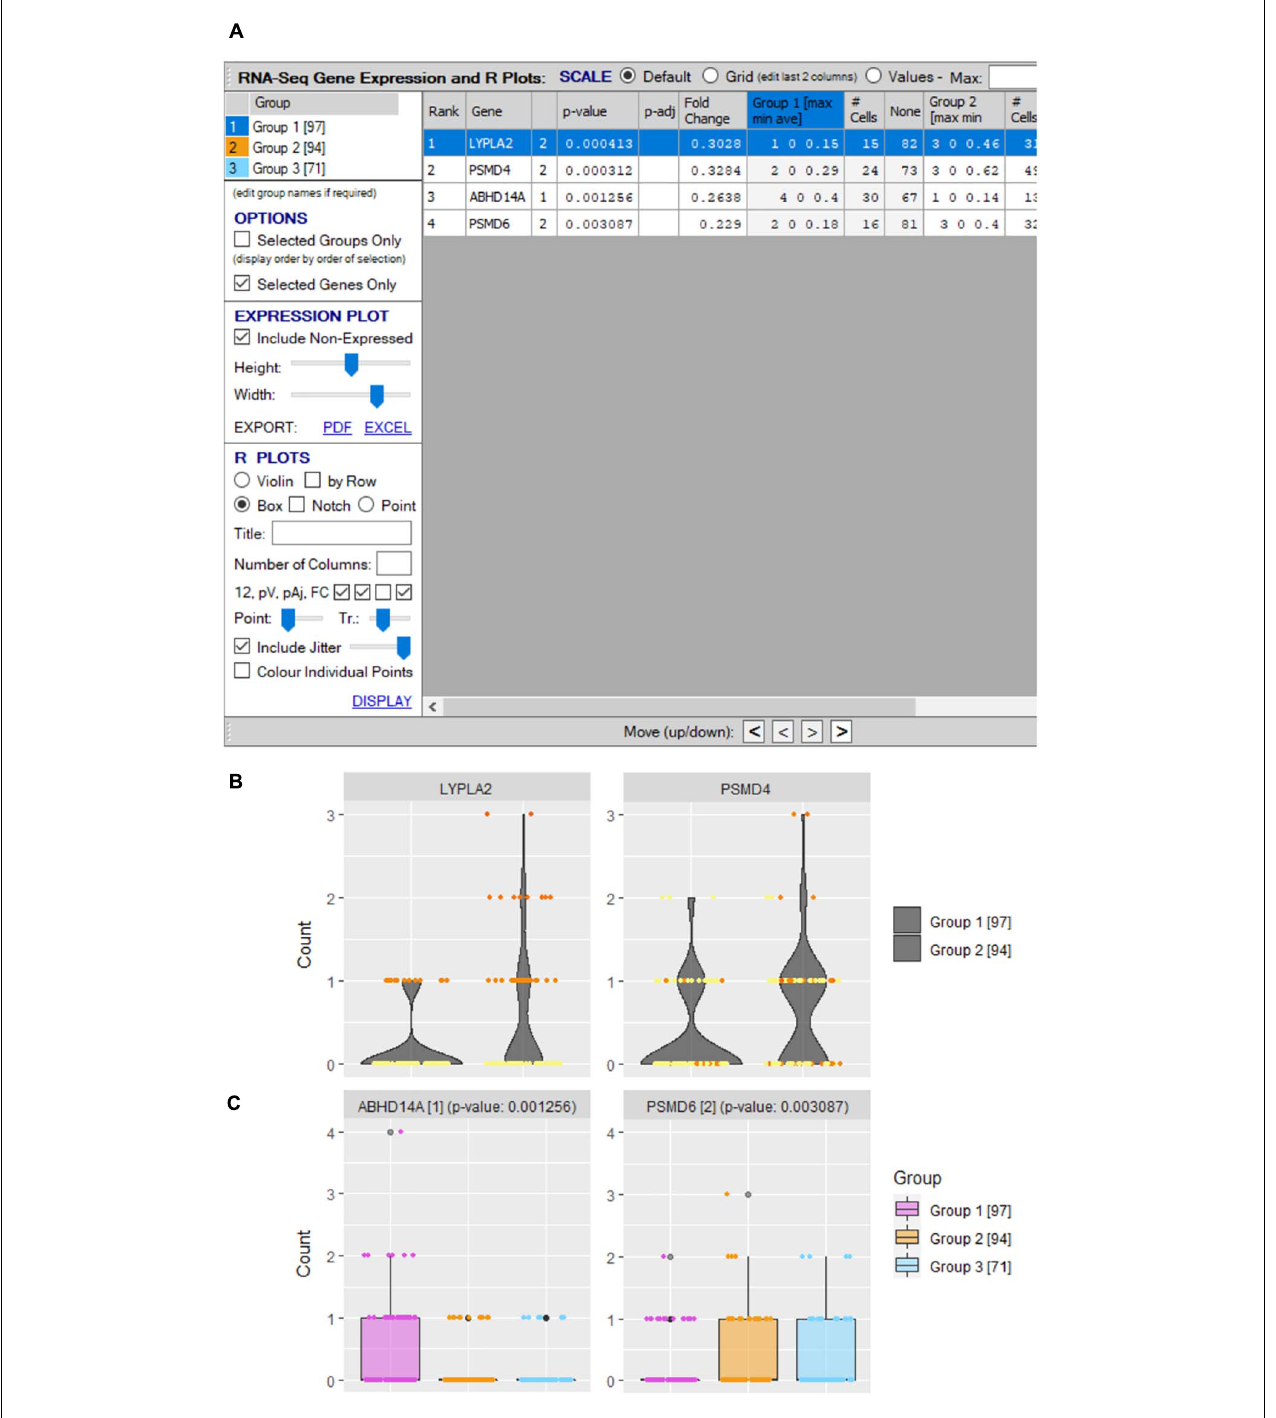
FIGURE 10 | Differential gene expression plots. (A) “scRNA-seq gene expression and R plots” window allows user to define genes for inclusion in single/comparative (B) violin and (C) boxplots with optional inclusion of jitters and defined heatmap coloring of groups.